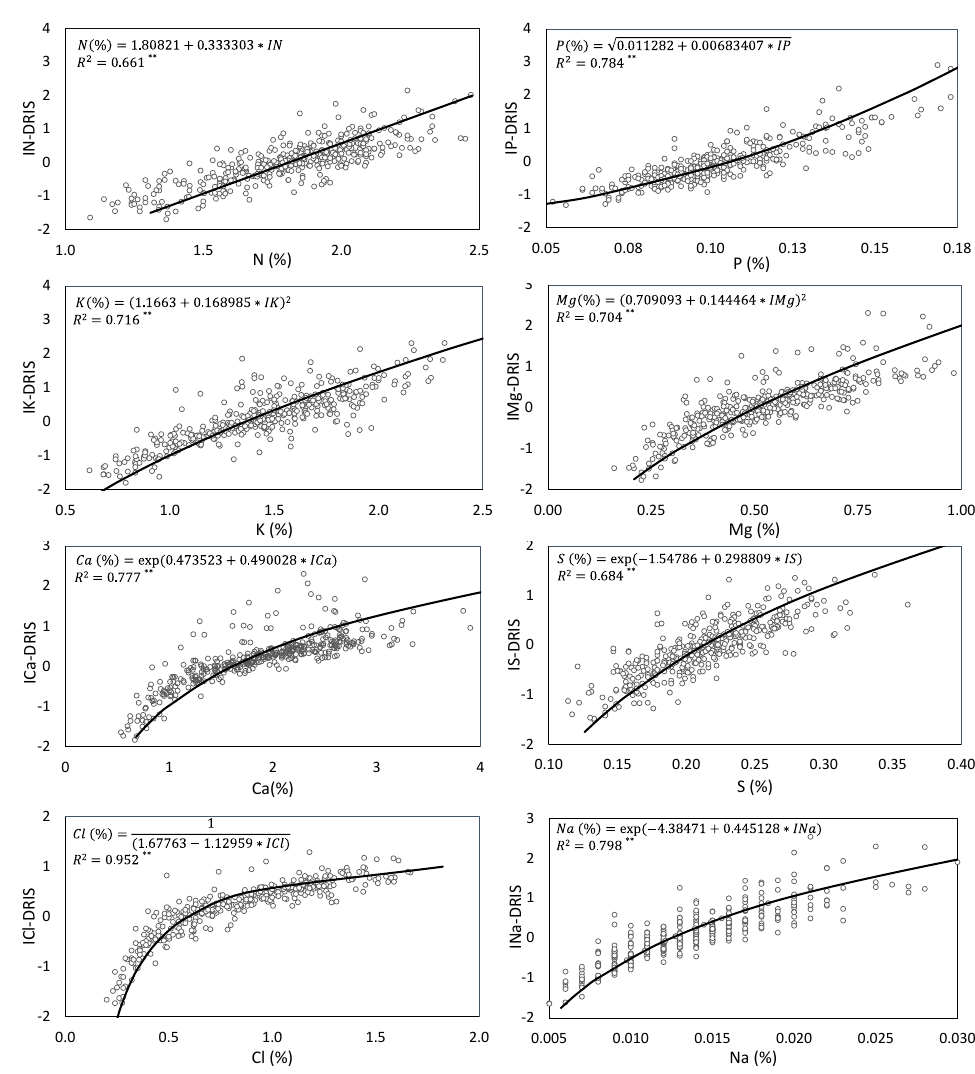
Figure 1. Relation between the leaf macronutrient concentrations in the high-yielding population and their corresponding nutrient DRIS indices (** indicates p < 0.01).